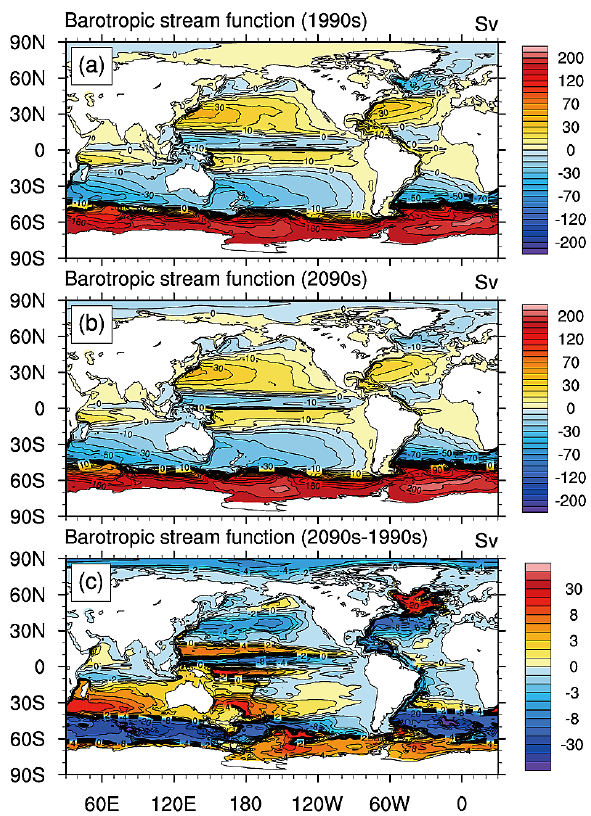
Fig. 2. Spatial distributions of the simulated barotropic (vertically integrated) stream function (Sv=10 6 m 3 s − 1 ) in the 1990s (a) and the 2090s (b) and their difference (c) . Positive (negative) values rep- resent clockwise (counterclockwise)